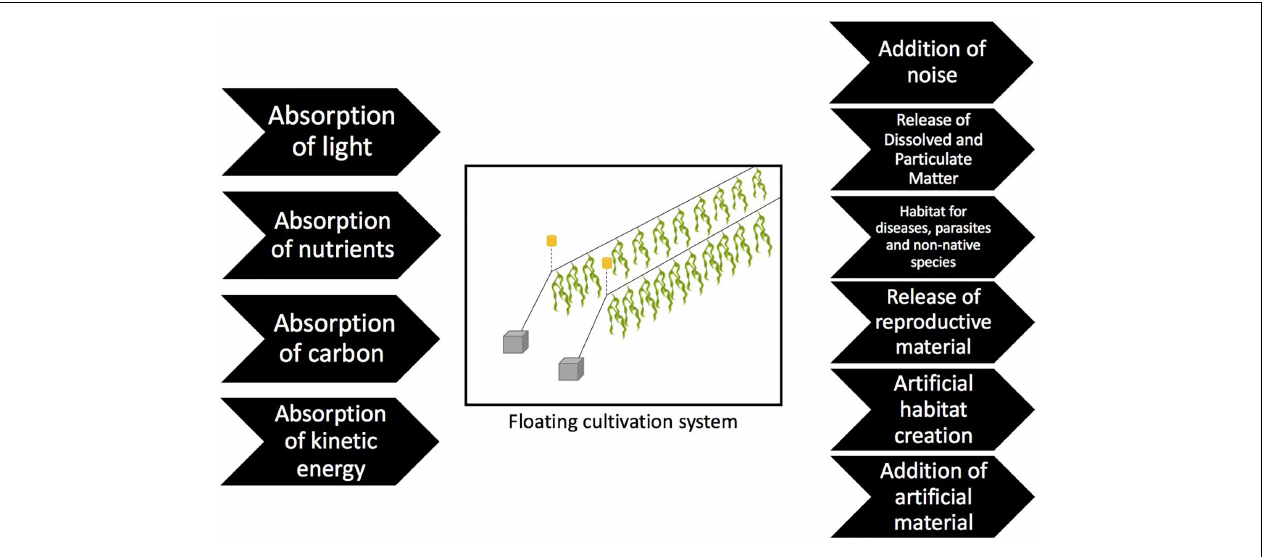
FIGURE 2 | Drivers of environmental change in relation to seaweed